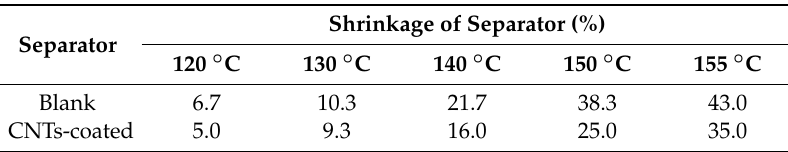
Table 1. Thermal shrinkage of blank separator and CNTs-coated separator.